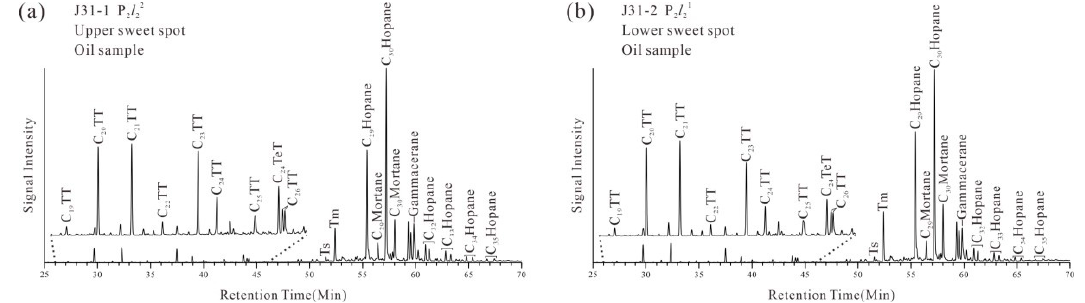
Figure 5. ( a ) Representative mass chromatograms (m/z 191) showing the tricyclic terpanes, tetracyclic terpanes; and ( b ) hopanes of saturated hydrocarbon fraction samples from the upper sweet spot and lower sweet spot.